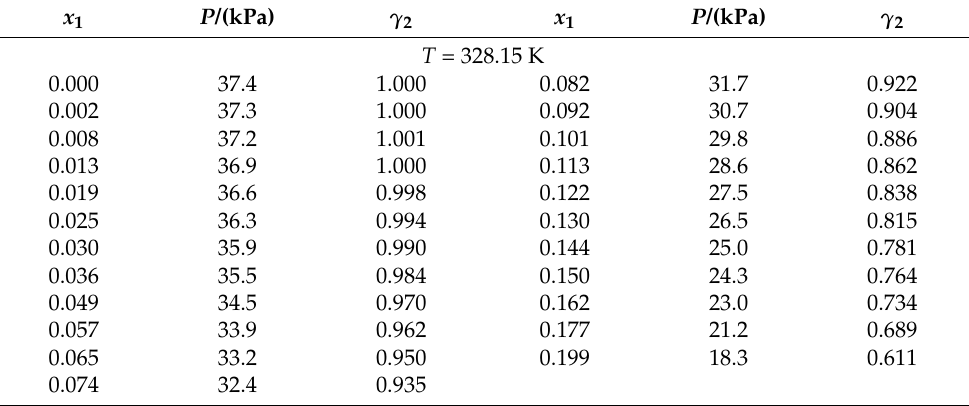
Table 3. Experimental P – T – x data for the {[C 1 C 2 PIP][DMP] (1) + Ethanol (2)} binary system: equilib- rium temperature, T /K; equilibrium pressure, P /kPa, ionic liquid mole fraction, x 1 ; activity coefficient of ethanol, γ 2 a